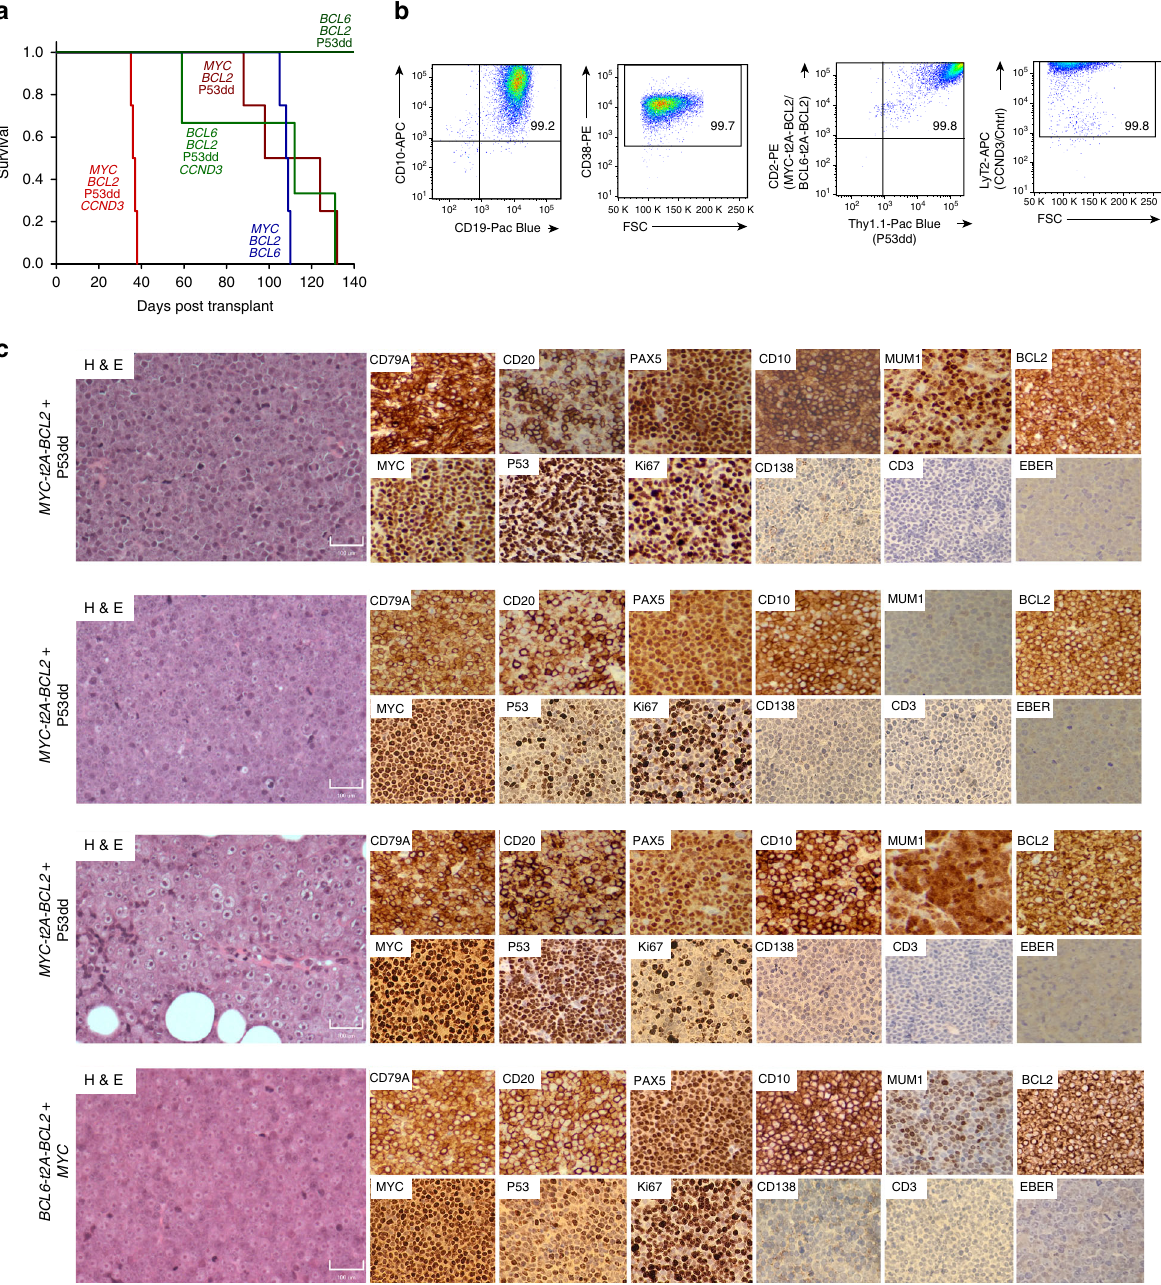
Fig. 5 Mutation-directed, in vivo models of human lymphoma. a Primary human GC B cells (as well as YK6-CD40lg-IL21 cells) transduced with the indicated oncogene cocktails were injected subcutaneously into NOD/SCID/gamma mice ( n = 3-4 per cohort) and monitored for palpable tumors. Mice were culled when tumors reached 12 mm in size. Survival of the recipient mice is plotted as a Kaplan – Meier curve. Source data are provided as a Source Data fi le. b Cells isolated from tumors were stained for the viral transduction markers CD2 ( MYC-t2A-BCL2 or BCL6-t2A-BCL2 ), Thy1.1 (P53dd), LyT2 ( CCND3 /Cntrl), and B cell markers CD19, CD10, and CD38 and were analyzed by fl ow cytometry. A representative example is shown. FSC forward scatter. c H&E and immunohistochemistry images for the indicated proteins are shown (magni fi cation ×20). Scale bar, 100 μ M. Four representative tumors from mice described in a are